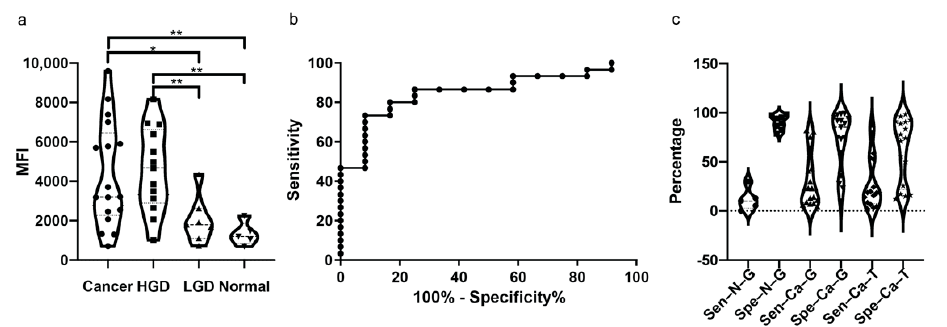
Figure 4. The fluorescent imaging results of 2-DG 800CW in patients’ biopsies. ( a ) The comparison results of the mean fluorescence intensity (MFI) in four different groups. The two-tailed Mann-Whitney U test is performed. * means p value < 0.05. ** means p value < 0.01. ( b ) The ROC curve analysis on the sensitivity and specificity of applying MFI in whole biopsy to distinguish cancerous tissue (including HGD and ESCC tissue) from LGD/normal tissue. ( c ) The sensitivity and specificity calculated on 4 µ m slices. Sen–N–G or Spe–N–G means the sensitivity or specificity, respectively, of 2-DG 800CW to detect GLUT1 expression on normal and LGD tissue; Sen–Ca–G or Spe–Ca–G means the sensitivity or specificity, respectively, of 2-DG 800CW to detect GLUT1 expression on HGD and ESCC tissue; Sen–Ca–T or Spe–Ca-T means the sensitivity or specificity, respectively, of 2-DG 800CW to detect tumor area on HGD and ESCC tissue.